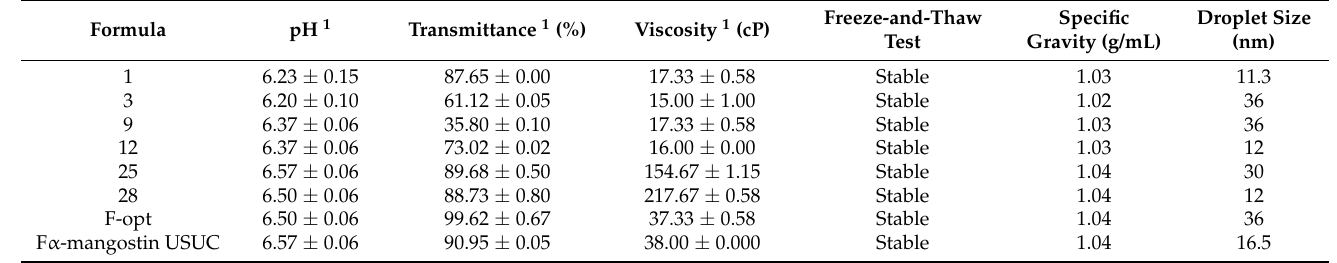
Table 4. Physicochemical properties of six selected USUC base formulae, the optimum base formula, and the α -mangostin-loaded optimal USUC formula.